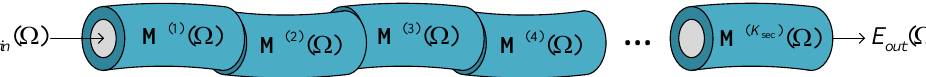
Figure 3. Strong-coupling optical fiber model as the concatenation of shorter fiber